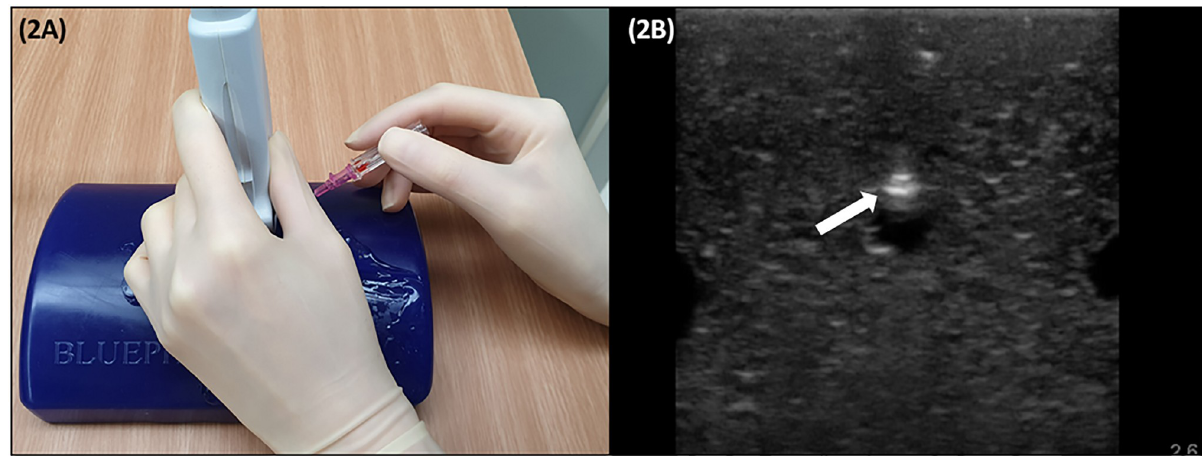
Fig 2. (A) Simulation training on Blue phantom paediatric 4 vessel ultrasound training block model. (B) Ultrasound image of the needle tip (hyperechoic dot, white arrow), located at midline of artificial vessel anterior wall. Out-of-plane method (short axis method).